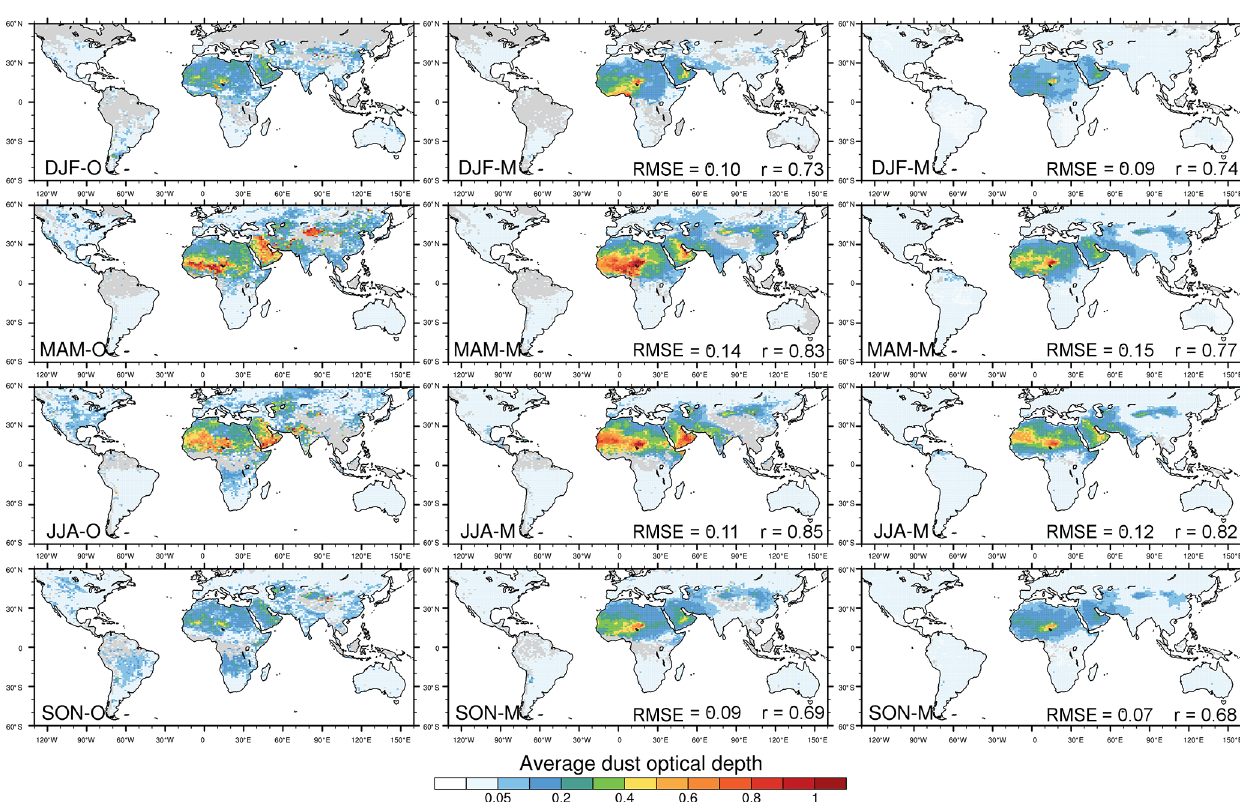
Figure 5. Seasonally averaged MODIS Deep Blue DOD (left), MONARCH all-sky DOD coarse at satellite overpass times co-located with MODIS DOD (middle), and clear-sky DOD coarse at approximate satellite overpass times derived from 3-hourly model output from MONARCH (right). The model results were obtained for DOD coarse averaged across the four model experiments. The seasonal averages were calculated with respect to the number of valid values per grid cell in the respective products. Area-weighted root mean square error (RMSE) and uncentered Pearson product-moment coefficient of linear correlation (r) between model and observations are indicated in the respective